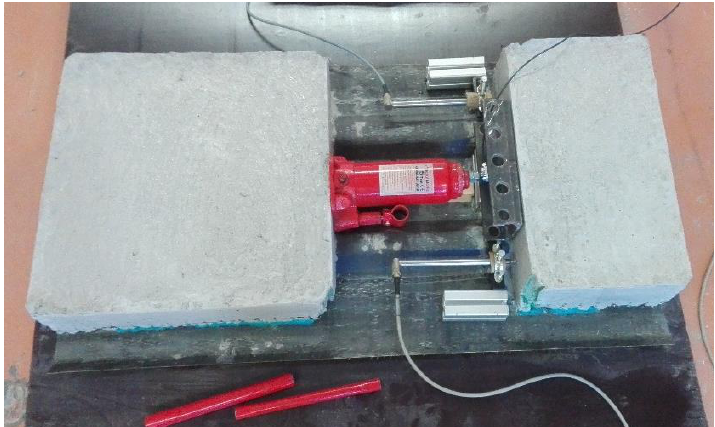
Figure 3. Shear test setup.